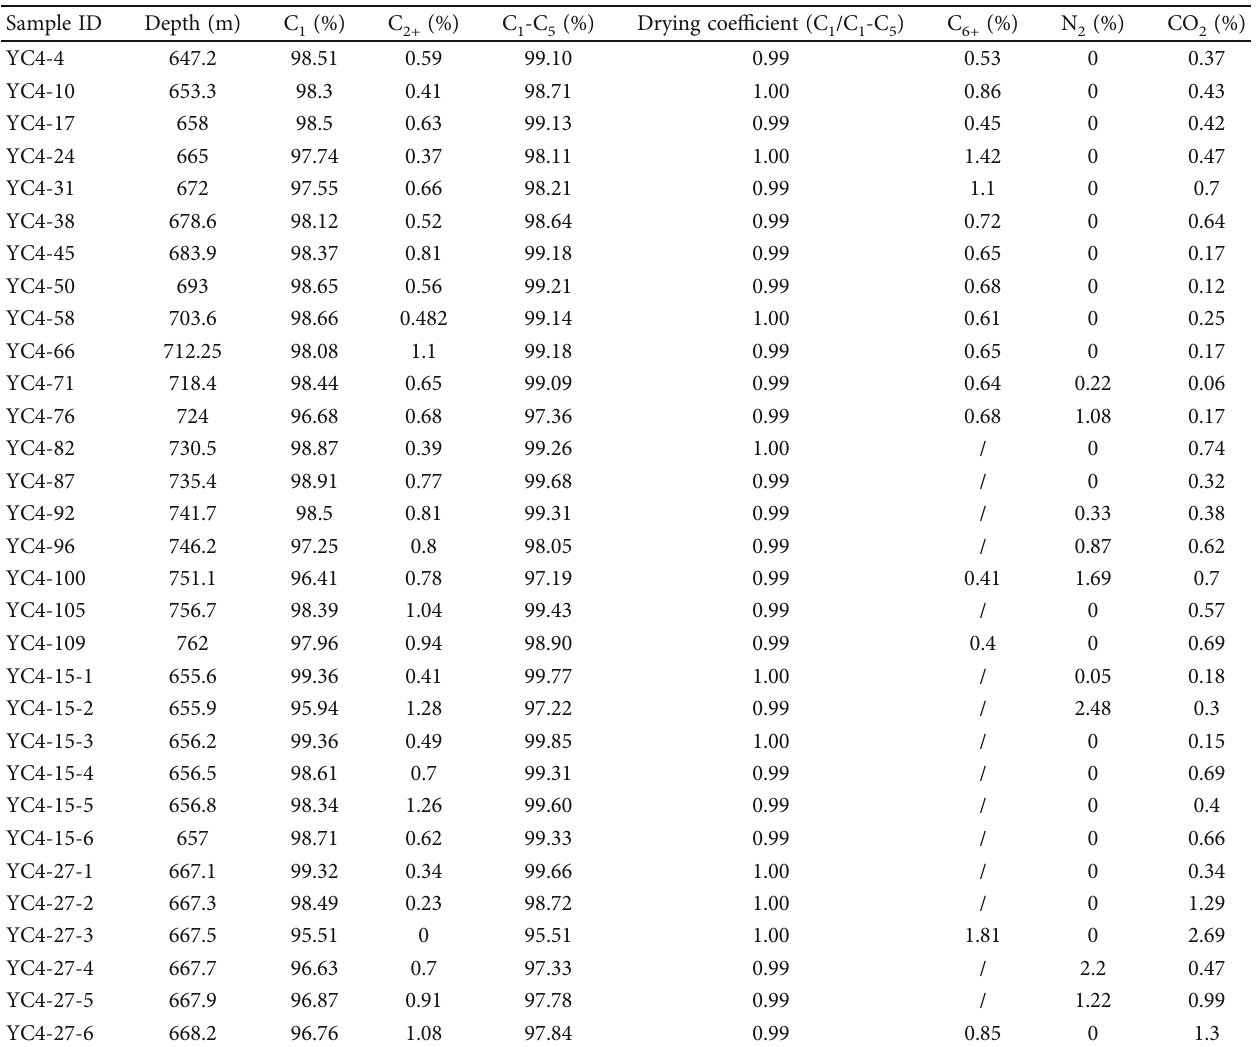
Figure 11: Gas content variation along with the buried depth of WL shale in Well-YC4. Table 2: Gas molecular composition of WL shale in